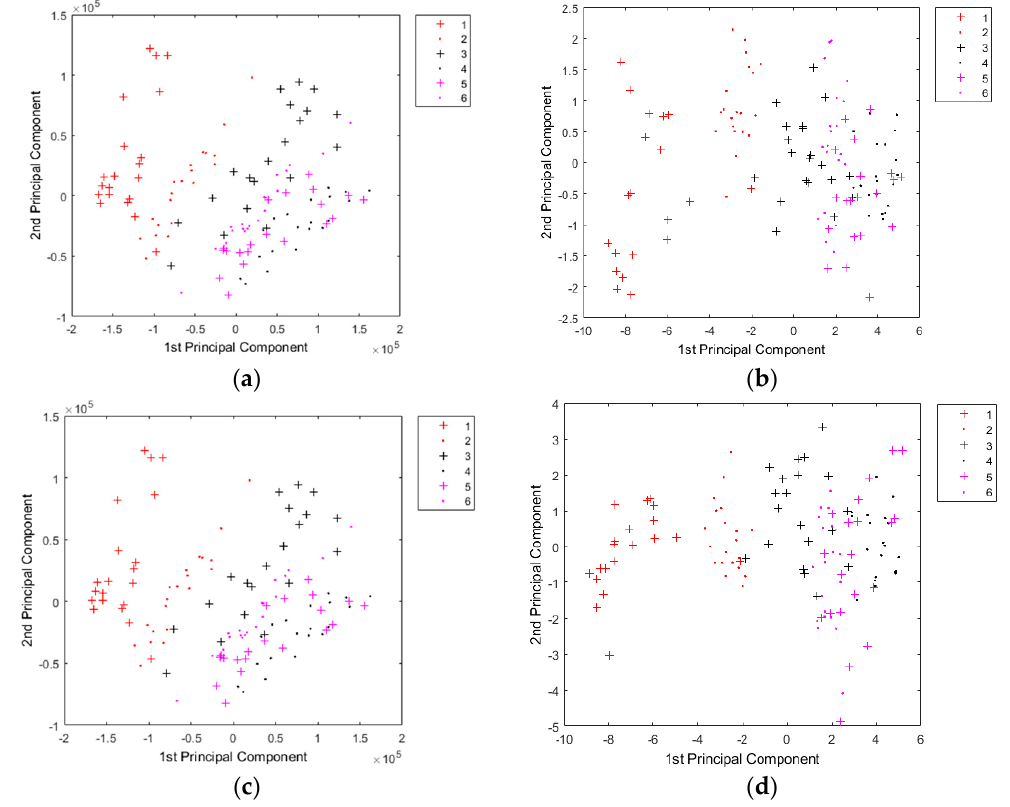
Figure 3. PCA plots using the LIBS data ( a ) before preprocessing and ( b ) after preprocessing, and the LIBS data combined with the HSI data ( c ) before preprocessing and ( d ) after preprocessing (concentrations of the pesticide solutions used in the samples from groups 1 to 6 were 0 g mL − 1 , 0.0050 g mL − 1 , 0.0025 g mL − 1 , 0.0017 g mL − 1 , 0.0013 g mL − 1 , and 0.0001 g mL − 1 ).